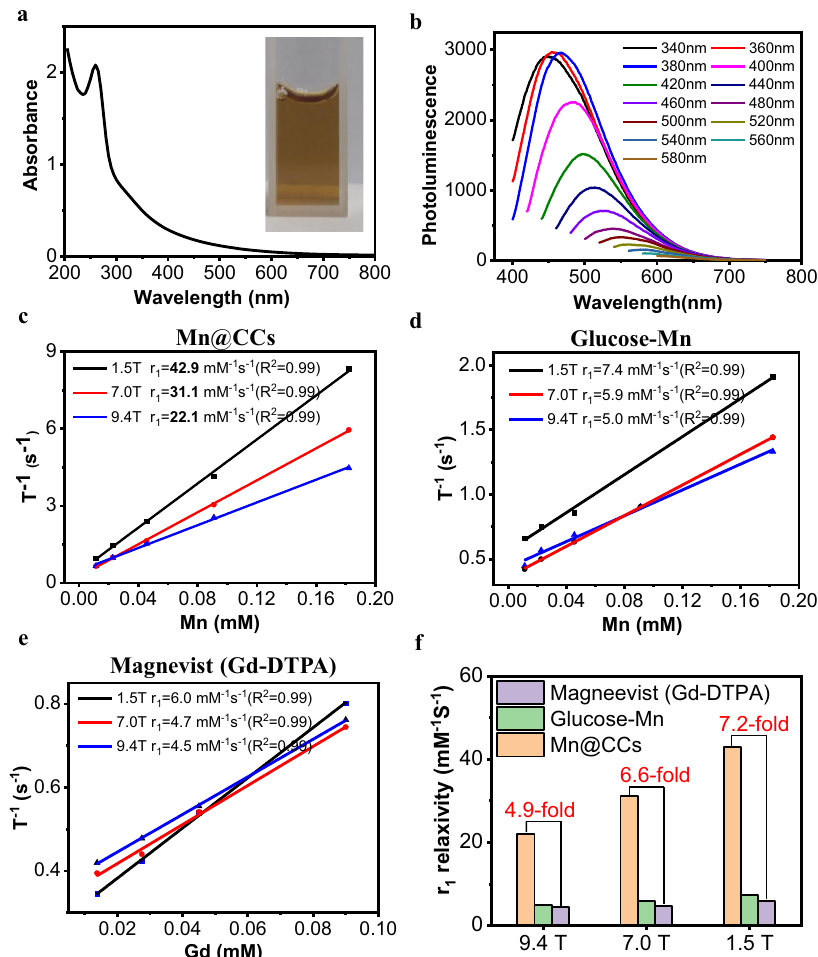
Fig. 2 Optical and magnetic properties of Mn@CCs. a UV-vis absorbance of Mn@CCs. Inset: Photograph of the puri fi ed Mn@CCs under daylight. b Photoluminescent spectra of Mn@CCs. c The r 1 relaxivities of Mn@CCs investigated in a 1.5 T, 7.0 T, and 9.4 T MRI system. d The r 1 relaxivities of glucose-Mn investigated in a 1.5 T, 7.0 T, and 9.4 T MRI system. e The r 1 relaxivities of Magnevist (Gd-DTPA) investigated in a 1.5 T, 7.0 T, and 9.4 T MRI system. f Comparison of r 1 relaxivities of Mn@CCs, glucose-Mn, and